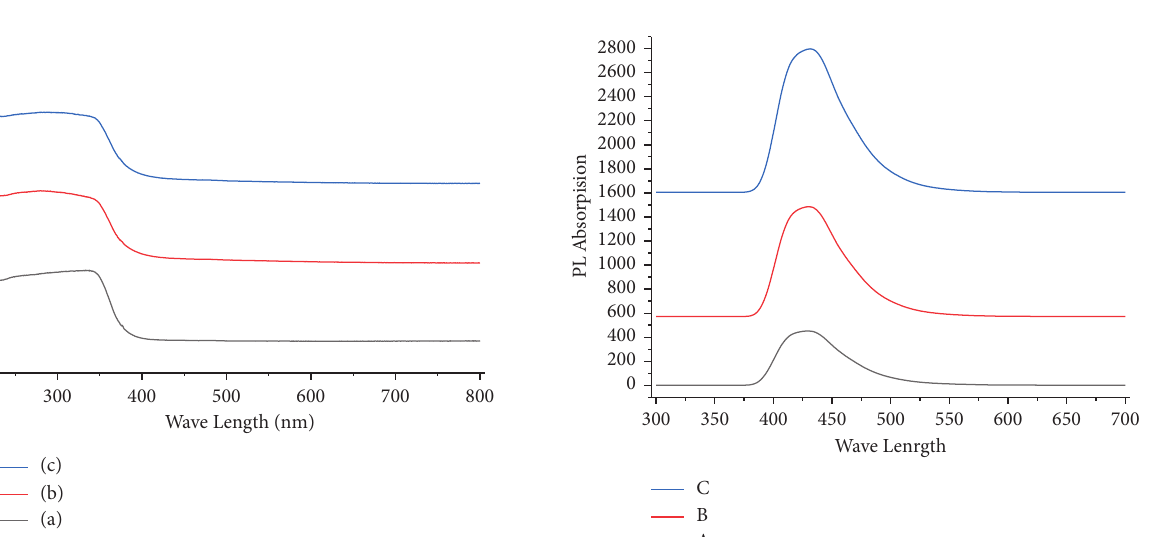
Figure 3: Plots of variation of optical absorption ( α t ) vs. wave- length films variation in bath temperature: (a) 20 ° C. (b) 45 ° C. Figure 4: Photoluminescence spectra of nano-synthesized PbSe films grown at different temperatures: (a) 20 ° C. (b) 45 ° C. (c) 85 ° C.